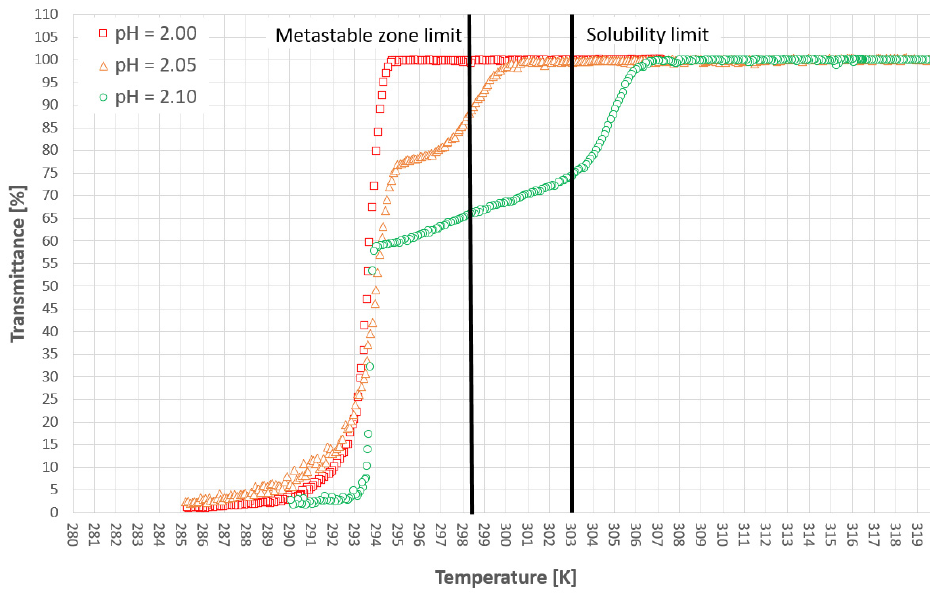
Figure 9. Process course for 27% w / w KCl solution.